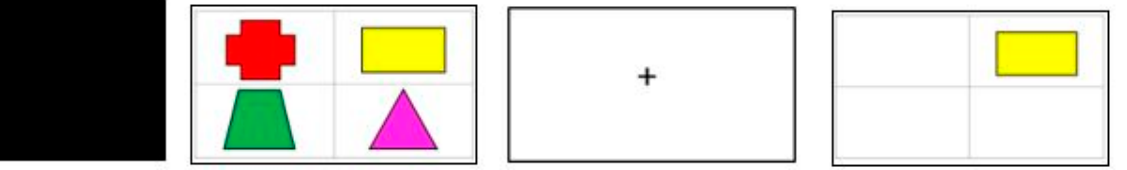
Figure 2. Picture sequence in VBT2.